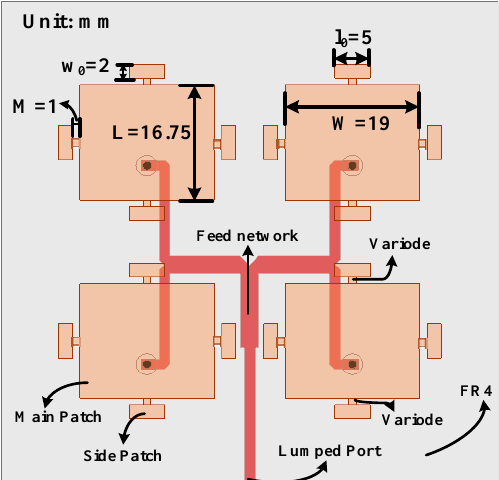
Figure 1. The general geometry of the patch antenna array (four smaller patches are all connected to the larger main patch).